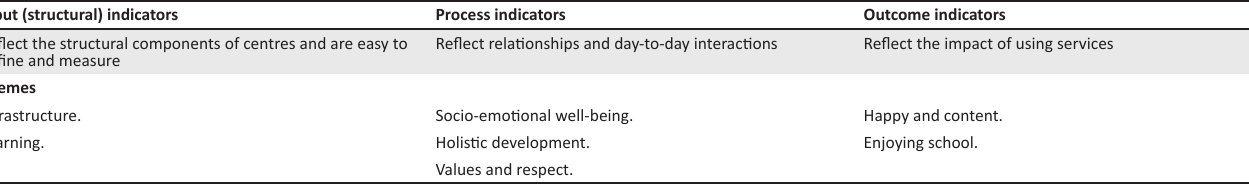
TABLE 2: Themes that emerged from the data, organised according to the quality indicators of the theoretical framework of Woodhead (see Table 1). Input (structural) indicators Process indicators Outcome indicators